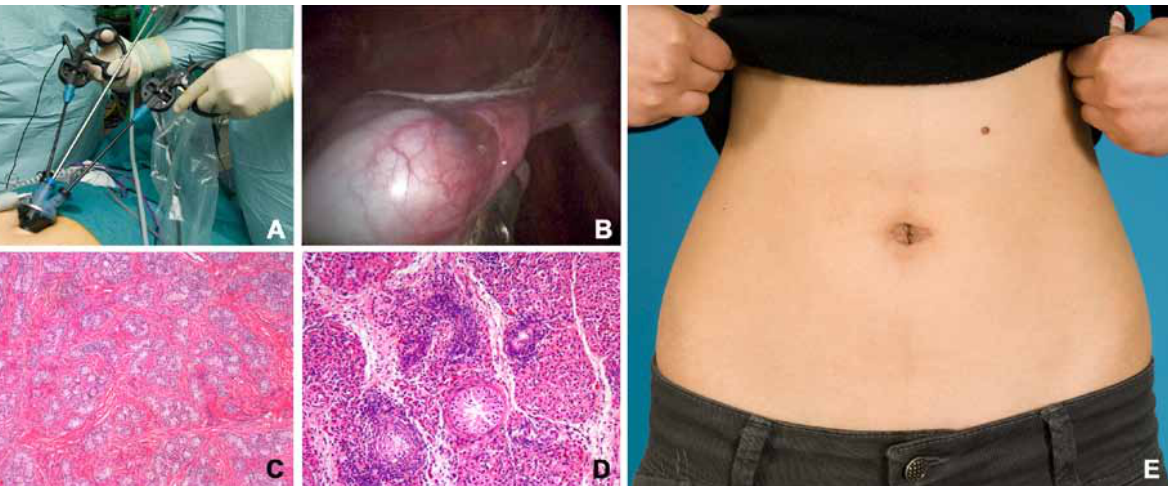
Figure 2 - Operative and postoperative results: Umbilical KeyPort with 30o 5.3 mm lens and duo-rotate instruments (A); laparoendoscopic view of the gonad (B); hamartomatous nodule composed of small tubules filled with Sertoli cells (C); Ley- dig cell hyperplasia and also a spindle-cell proliferation very similar to ovarian stroma (d); absence of visible incision two weeks after surgery